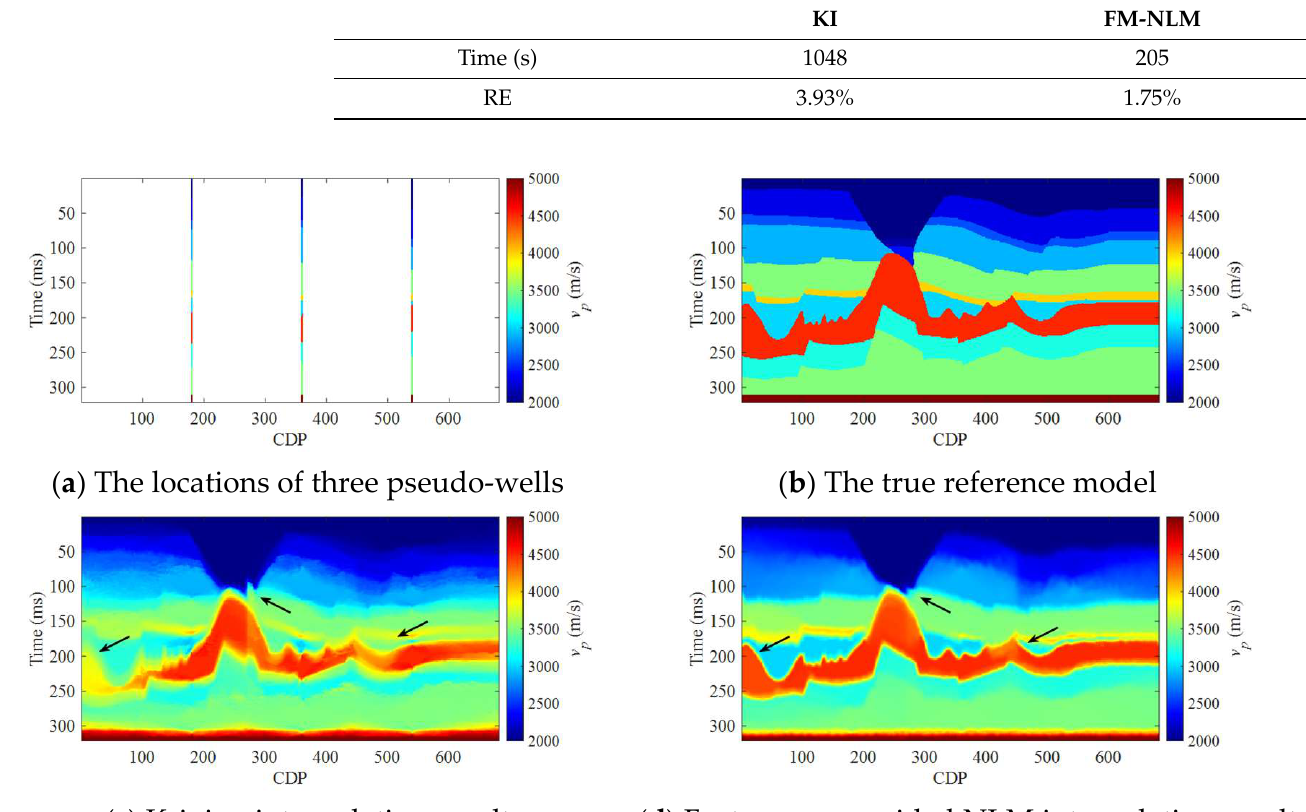
Figure 8. The interpolation results from noisy seismic records.